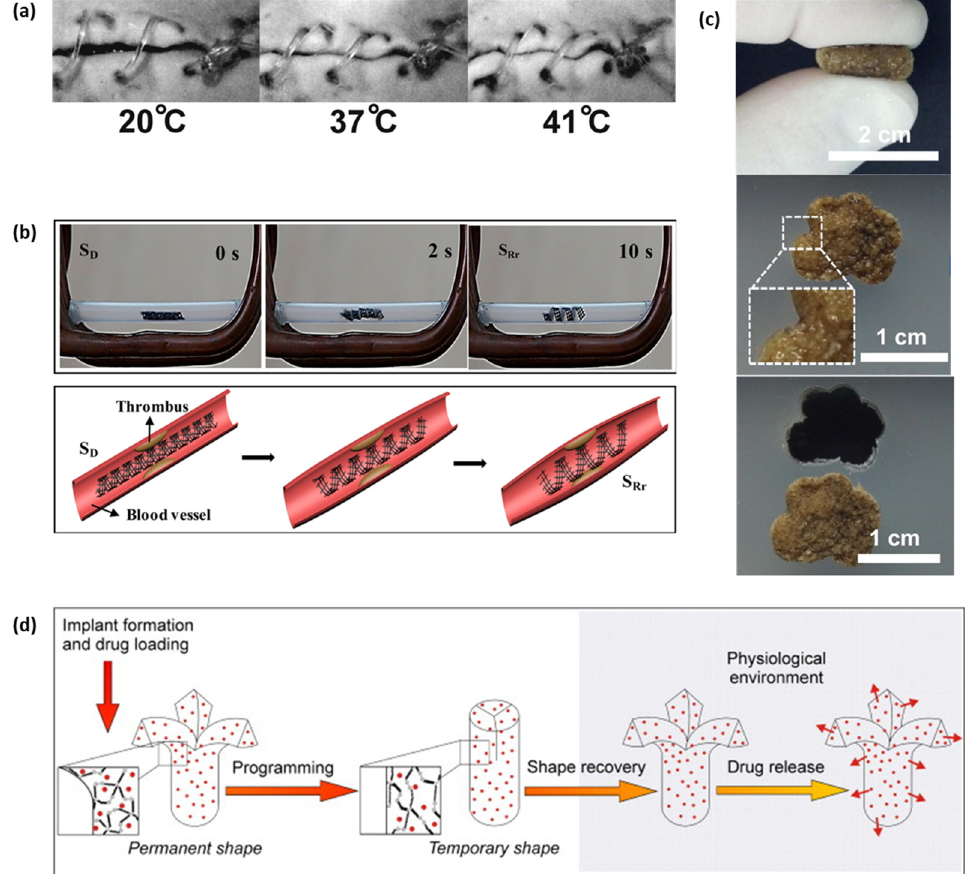
Figure 6. Biomedical applications of BSMPs. ( a ) The photo series of suture for wound closure from the animal experiment shows ( left to right ) the shrinkage of the fiber while temperature increases. (Adapted with permission [22] © 2002, American Association for the Advancement of Science); ( b ) demonstration of the restrictive shape recovery process triggered by a 30 kHz alternating magnetic field; potential application of the 4D scaffold as an intravascular stent. Here, the deformation temperature was 80 °C. Therefore, S D , and S Rr represent for the original, deformed, and recovery shapes under restrictive conditions, respectively (adapted with permission [90] ©2017, American Chemical Society); ( c ) self-fitting behavior of a polydopamine-coated PCL SMP scaffold (adapted and reproduced with permission [60] © 2014, Elsevier); ( d ) concept of programming, shape recovery, and drug release of drug loaded SMP devices (adapted with permission [91] ©2009, Elsevier B.V.).